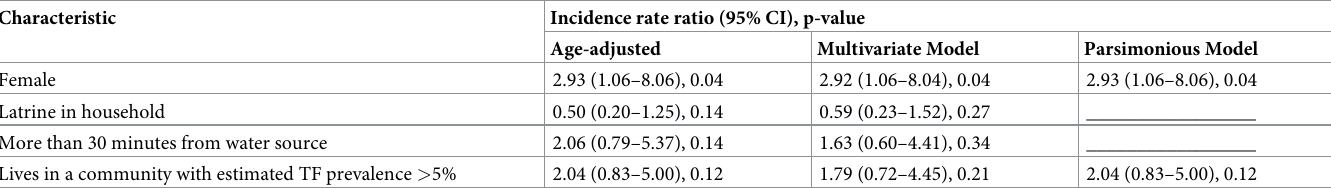
Table 4. Models predicting incidence of